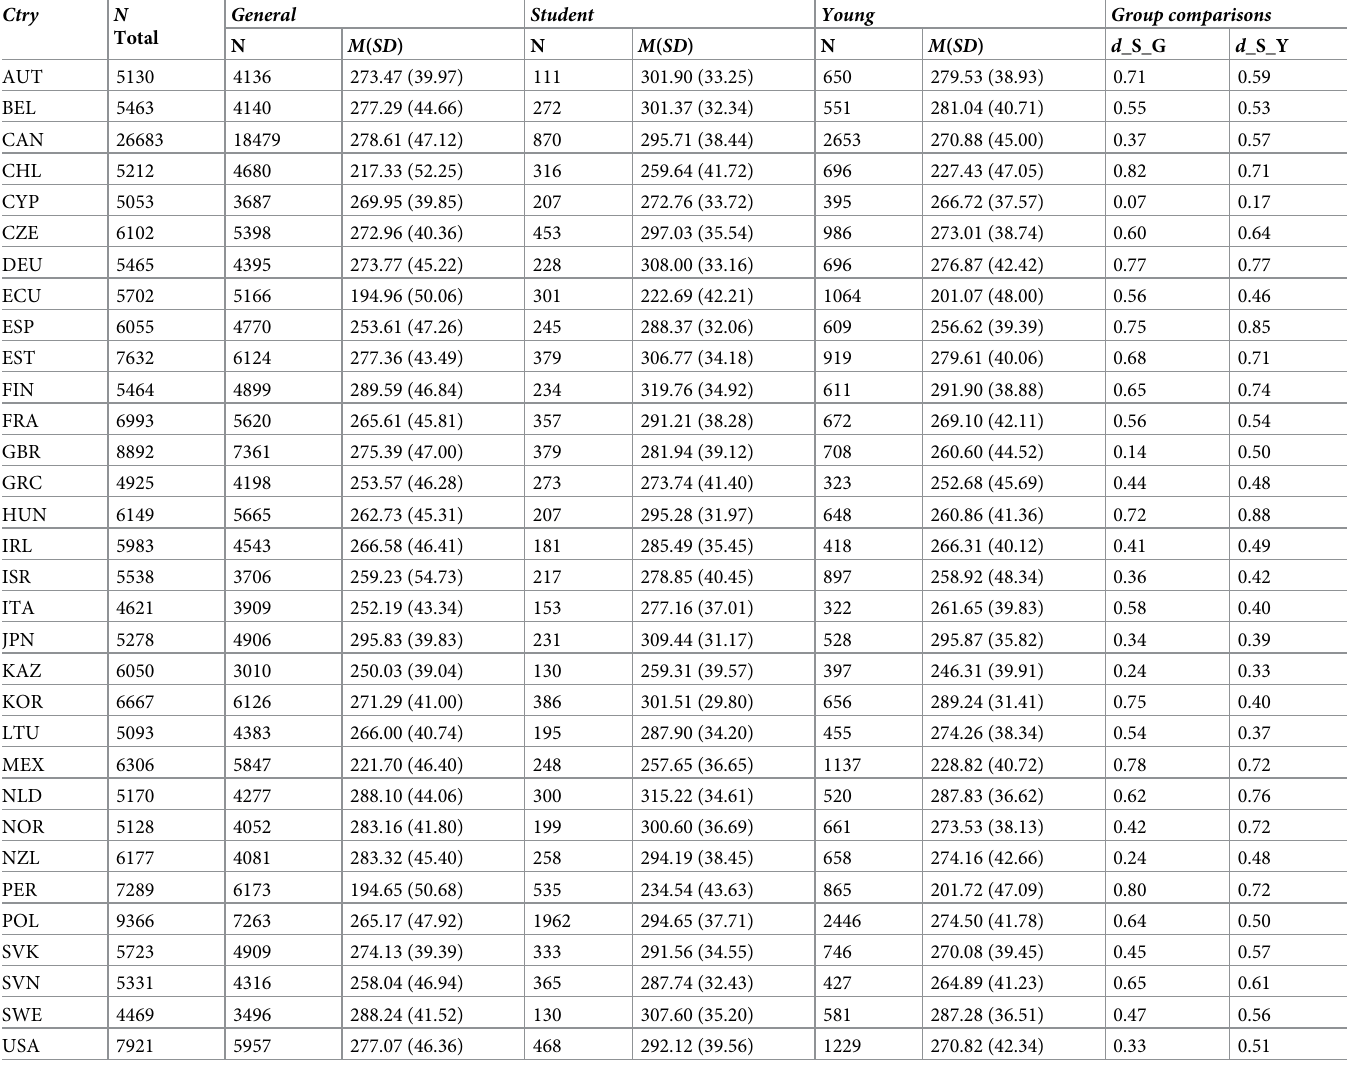
Table 1. Descriptive statistics of literacy for the General, Young, and Student national samples, and Cohen’s d estimates of differences between Student and General samples, and Student and Young samples, presented by